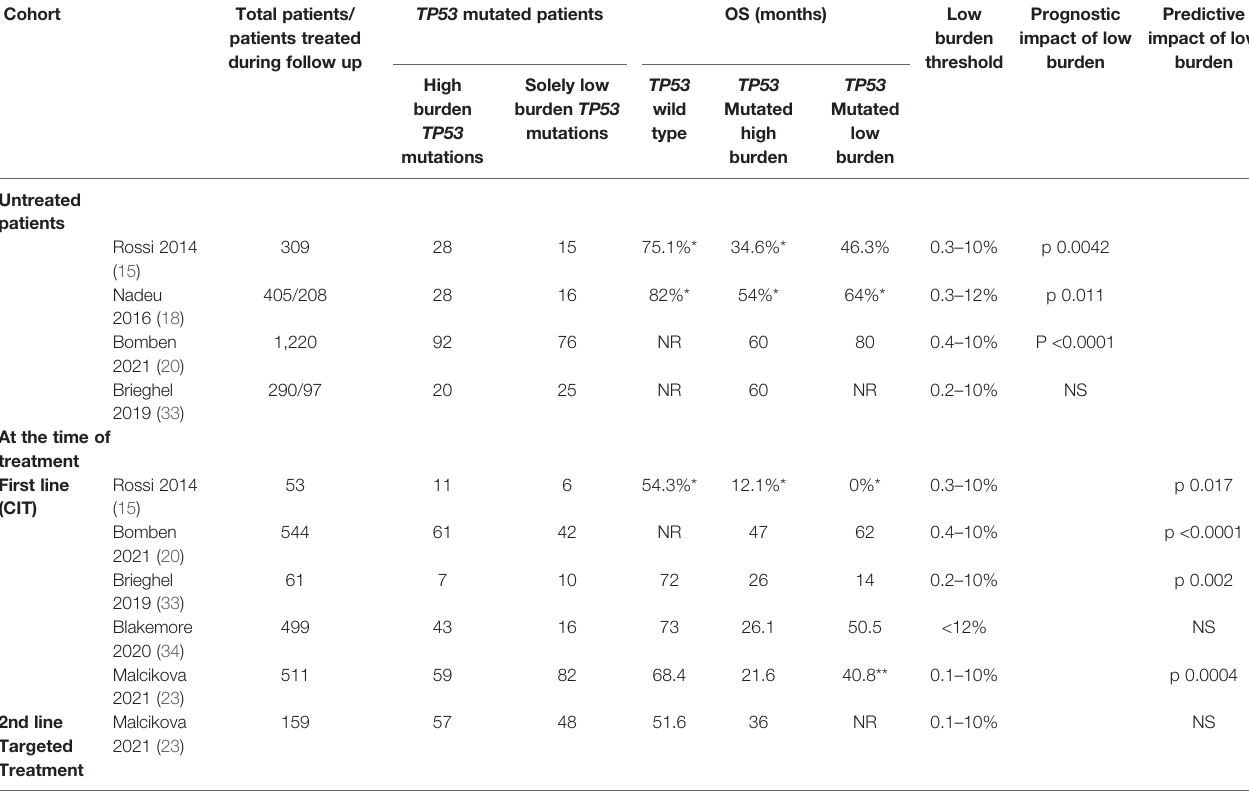
TABLE 1 | Summary of the prognostic and predictive impact of TP53 mutations evaluated in 6 studies in CLL.